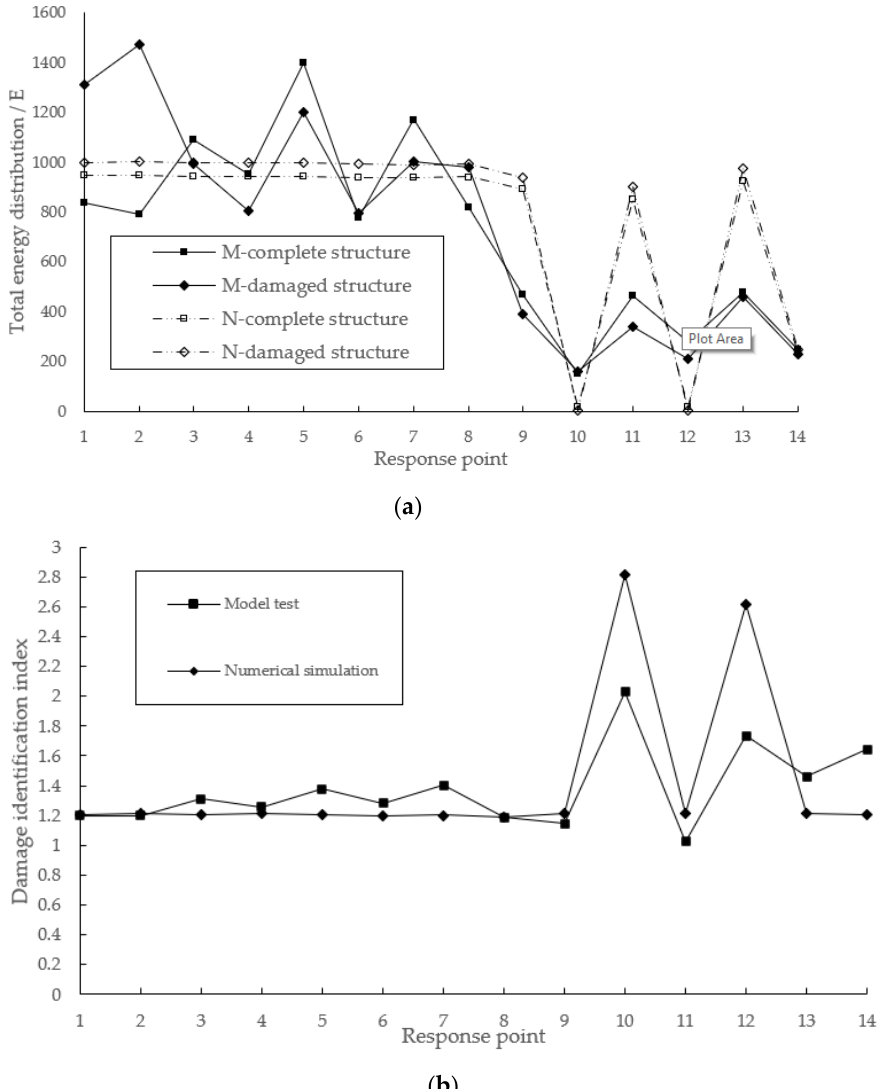
Figure 13. Comparison between model test and numerical simulation of transient dynamic response of wharf frame structure. Attachment: M—model test; N—numerical simulation. ( a ) Comparison of total energy distribution of transient acceleration between model test and numerical simulation. ( b ) Comparison of damage identification indexes between model test and numerical simulation.